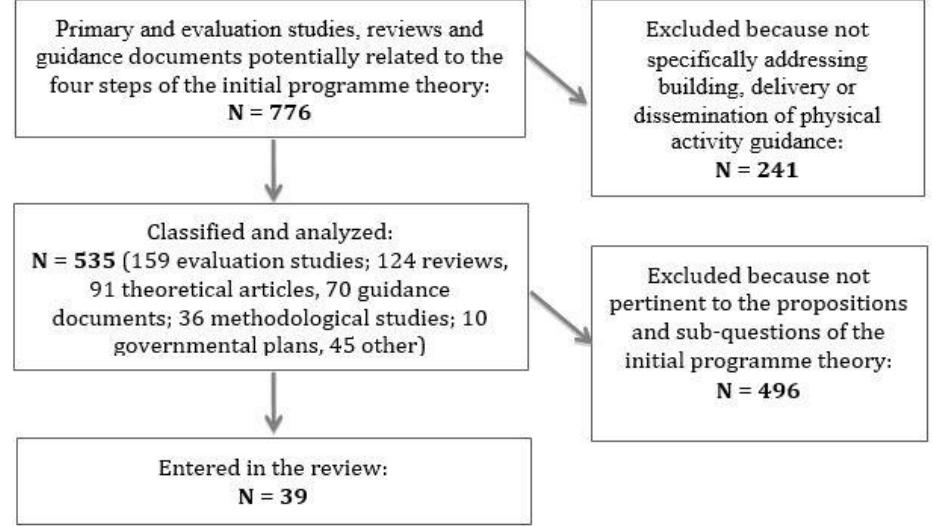
Figure 2. Selection strategy flow diagram.